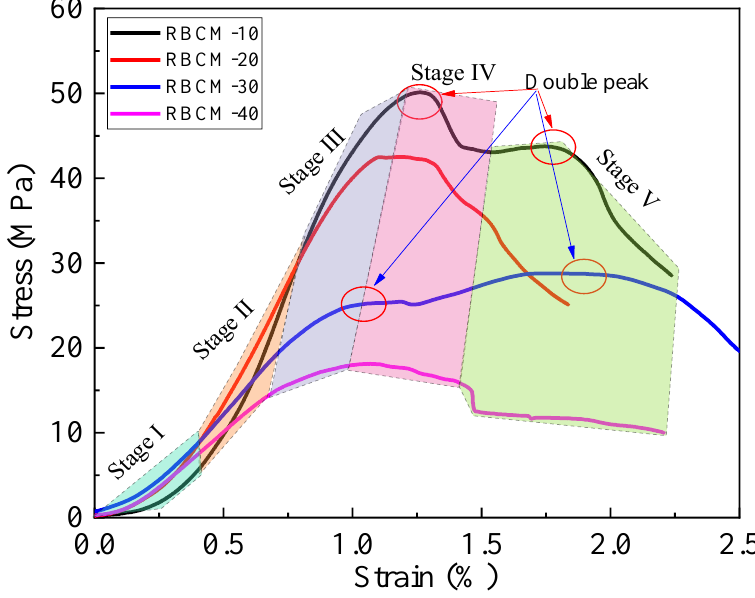
Figure 5. Stress–strain curves of the RBCM samples. Figure 5. Stress – strain curves of the RBCM samples.